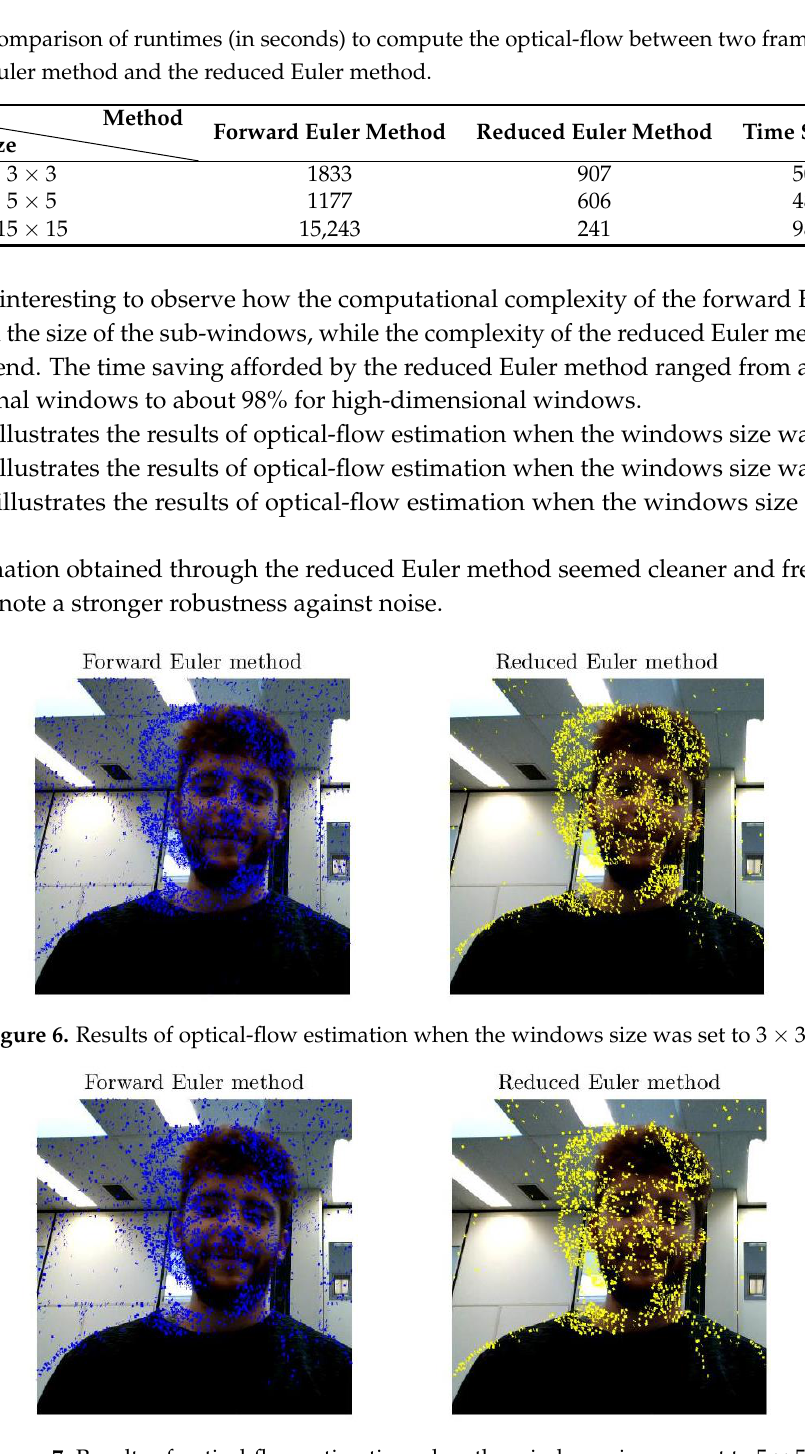
Figure 7. Results of optical-flow estimation when the windows size was set to 5 ×